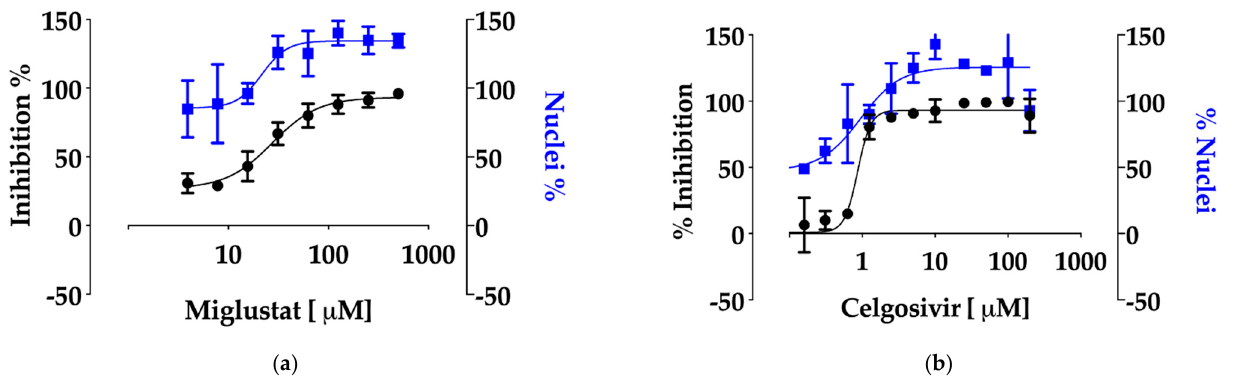
Figure 3. Anti-SARS-CoV-2 activity of Miglustat and Celgosivir. ( a ) Dose response of Miglustat in Huh-7hACE2 cells. Miglustat, at the indicated concentrations, was added to cell monolayers infected with SARS-CoV-2. Following incubation for 20 h, the cells were fixed and stained with the anti-Spike recombinant antibody mSIP-3022. Immunofluorescence images of infected cells (black) and the number of nuclei (blue) were collected and analysed by the Operetta high content imaging system using the Columbus Image Data Storage and Analysis software. ( b ) The dose response of Celgosivir in Huh7-hACE2 cells. Celgosivir, at the indicated concentrations, was added to cell monolayers infected with SARS-CoV-2 and processed as above.